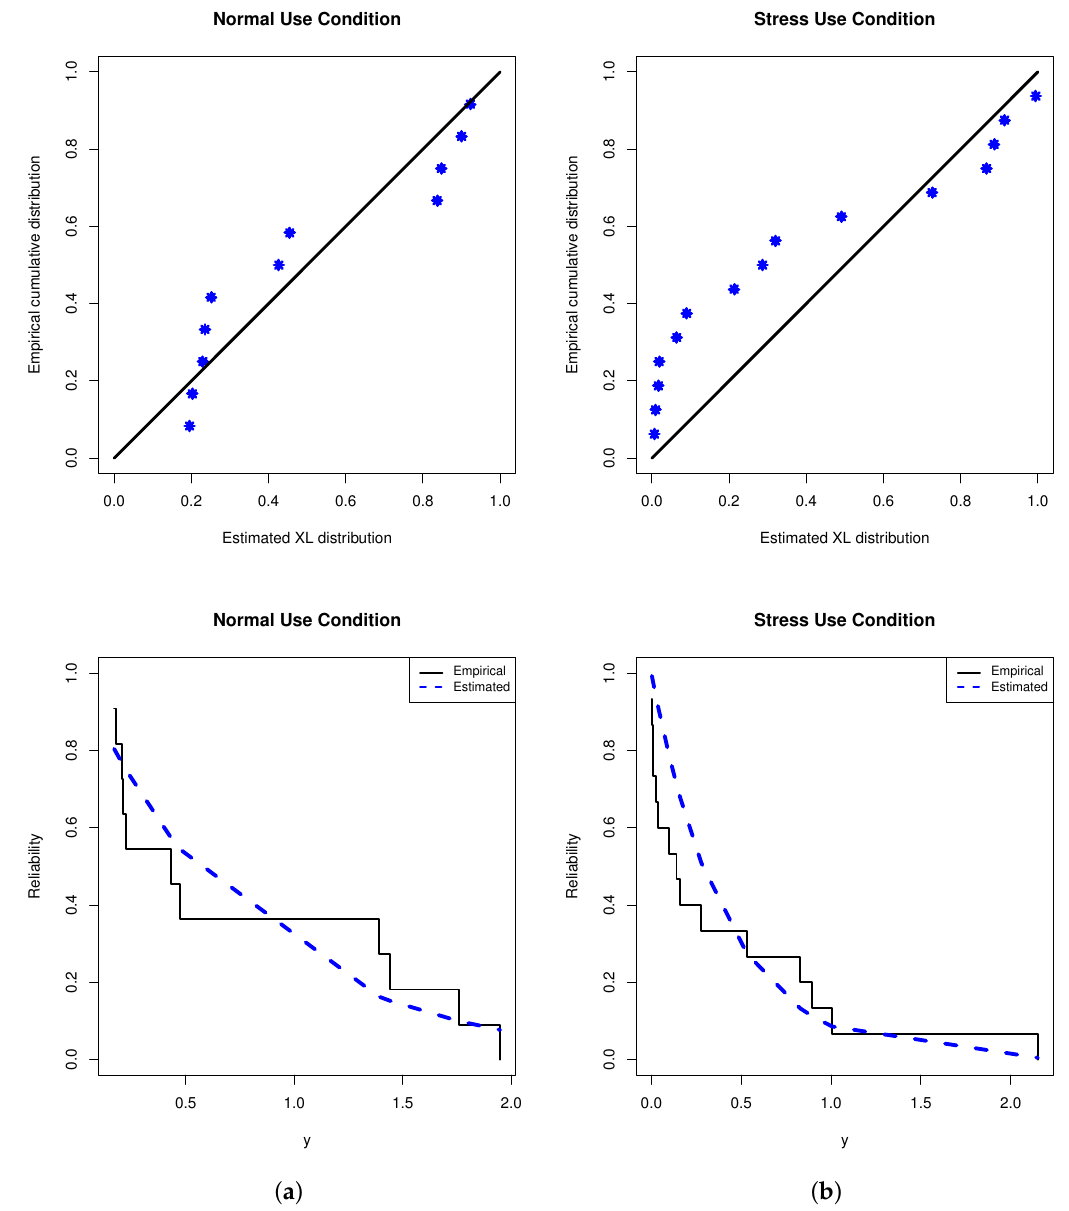
Figure 7. Fitted RF ( right ) and PP ( left ) plots from OBT data. ( a ) Normal condition; ( b ) stress condition. In this part, to see the usefulness of the derived point/interval estimators, several PT- IIC samples from the OBT data sets are obtained. From Table 1, taking different options of ) , 3 artificial samples the effective samples m j , i = 1, 2 and censoring plans ( R j 1 , R j 2 , . . . , R jm j are created and listed in Table 2. Here, for brevity, the scheme ( 1, 1, 1, 1, 1 ) is considered as ( 1 5 ) . So, for each generated sample, the point estimates (including the maximum likelihood and Bayes estimates) and the interval estimates (including the asymptotic and credible interval estimates) of λ , β , α u , G u ( t ) and H u ( t ) (for distinct time t = 1 and the normal operating level x u = 25) are calculated. Obviously, we do not have any prior information about λ and β ; thus, we set a = b = c = d = 0.001 which means that the posterior density becomes quite close to the likelihood function. We also run the proposed MCMC procedure with a burn-in of 10,000 followed by 40,000 iterations. Thus, the Bayes point (or credible interval) estimates are evaluated. The initial values of β and δ for beginning our iterations are taken as ˆ λ and ˆ β , respectively. However, in Table 3, the point estimates (with